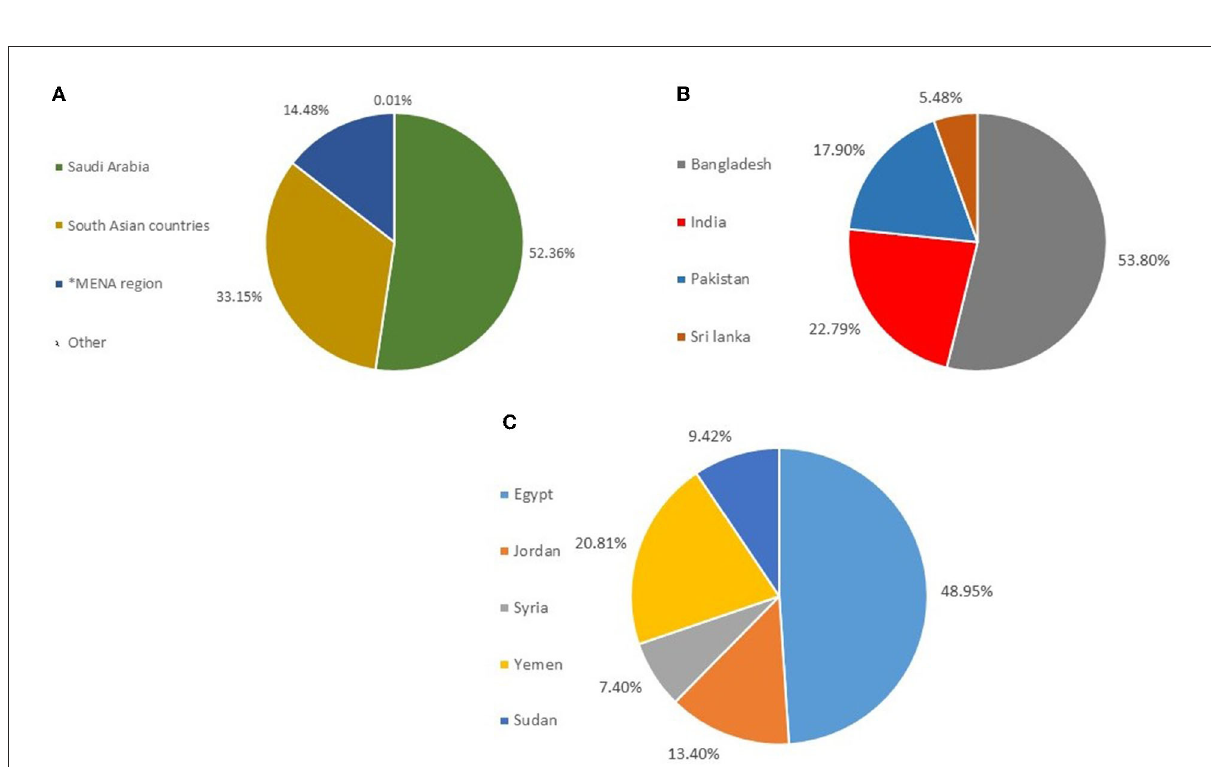
FIGURE2 Distribution of nationalities in the studied population. (A) Distribution of Nationalities in Saudi Nationals, South Asian Counties, and MENA. (B) Distribution of Nationalities in South Asian countries (C) Distribution of Nationalities in MENA countries. *MENA, Middle East North